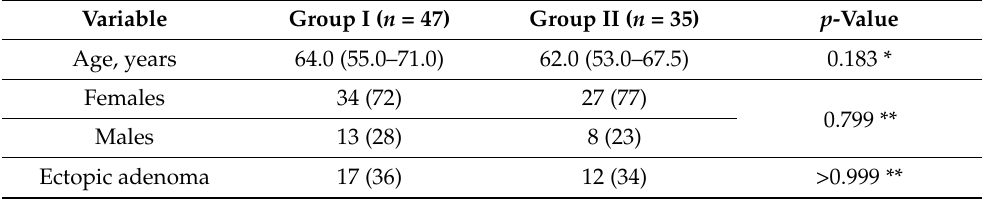
Table 1. Characteristics of the study